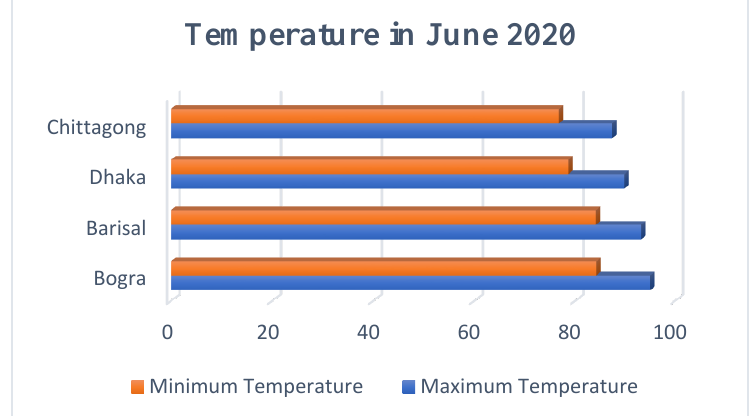
Figure 6. Maximum and minimum temperatures of the four districts in June 2020.